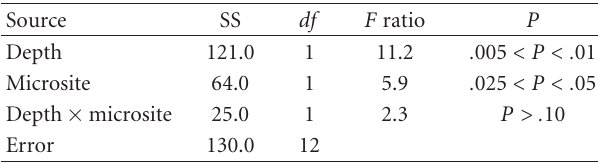
Table 3: ANOVA of the e ff ects of soil depth and microsite on maximum temperatures recorded during a controlled burn in sand pine scrub at Archbold Biological Station, Florida. Temperatures were recorded with copper-constantan thermocouples placed at the soil surface and at 2 cm depth, and in open and vegetated microsites. Data were rank-transformed prior to the ANOVA.